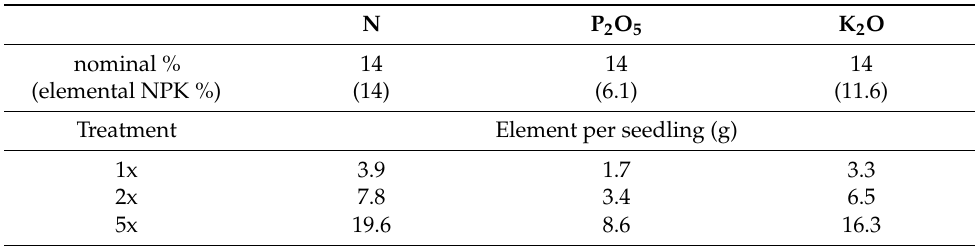
Table 1. Fertilizer treatments applied in the Guam